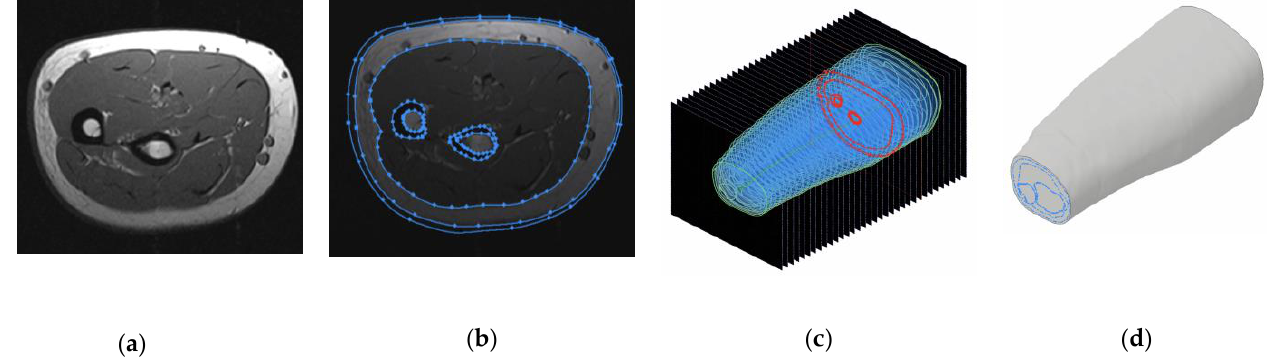
Figure 5. Volunteers’ forearms MRI images reconstruction: ( a ) MRI slice; ( b ) contouring of the slice; ( c ) contoured slices series; ( d ) forearm 3D reconstruction.